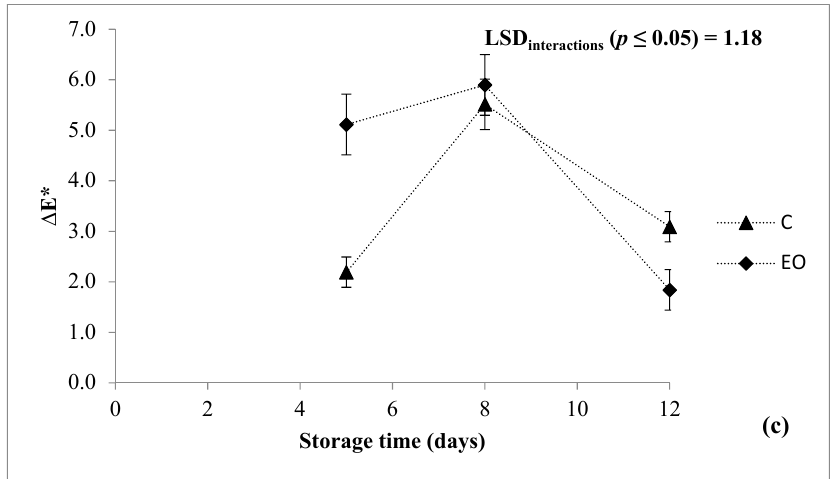
Figure 3. Color parameters of RTC globe artichoke slices as affected by “genotype × post-harvest treatment × storage time”( a ) “genotype × storage time” ( b ); “post-harvest treatment × storage time”( c ) interaction. L*: Lightness; Δ E* = total color difference; O: “Opera F1”; SS: “Spinoso sardo”; C: control; EO: Samples packed with essential oil of F. vulgare . Data are presented as means ± standard deviation.